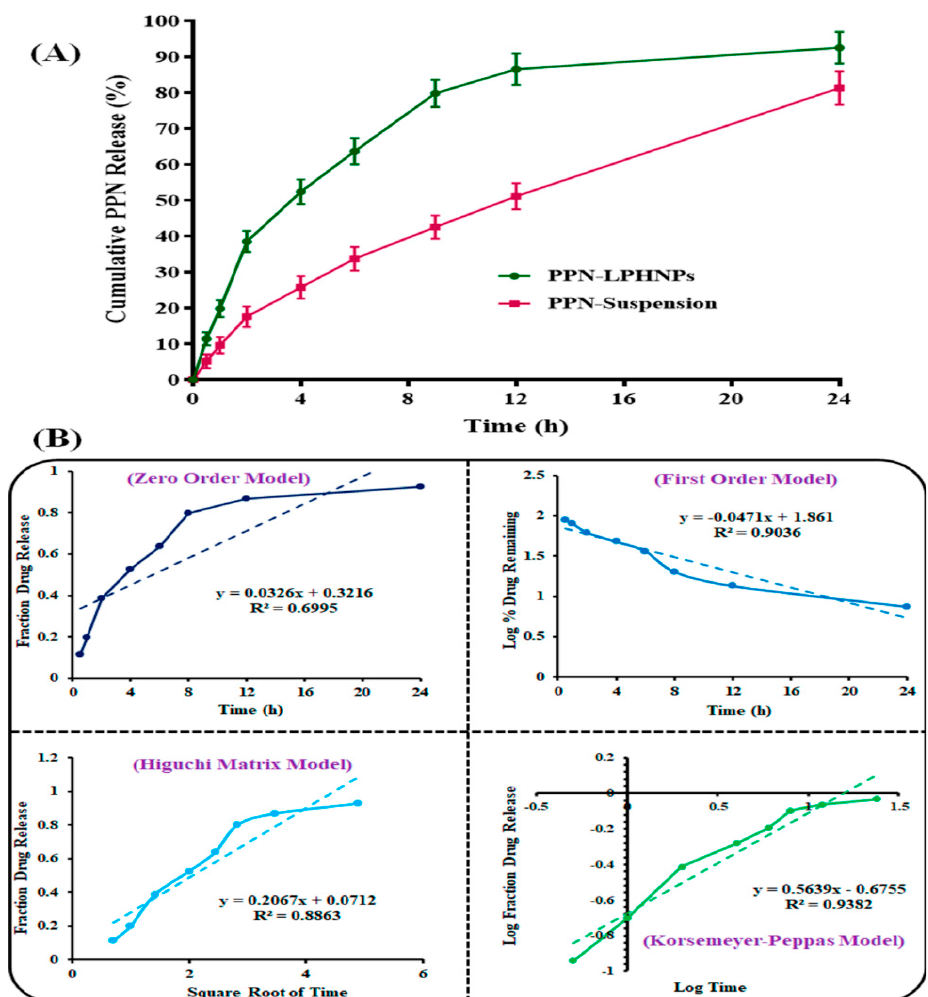
Figure 7. Image representing ( A ) PPN release profiles from the optimized PPN-LPHNPs and PPN suspension and ( B ) various kinetic models for optimized PPN-LPHNPs to understand the mechanism.